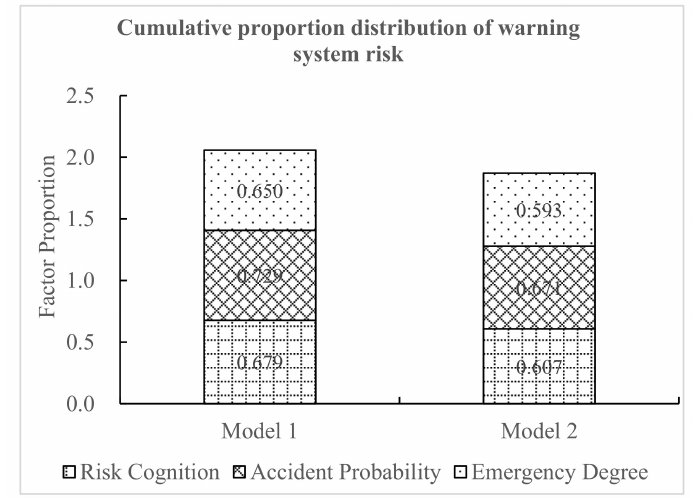
Figure 17. Cumulative proportion distribution of warning system risk.